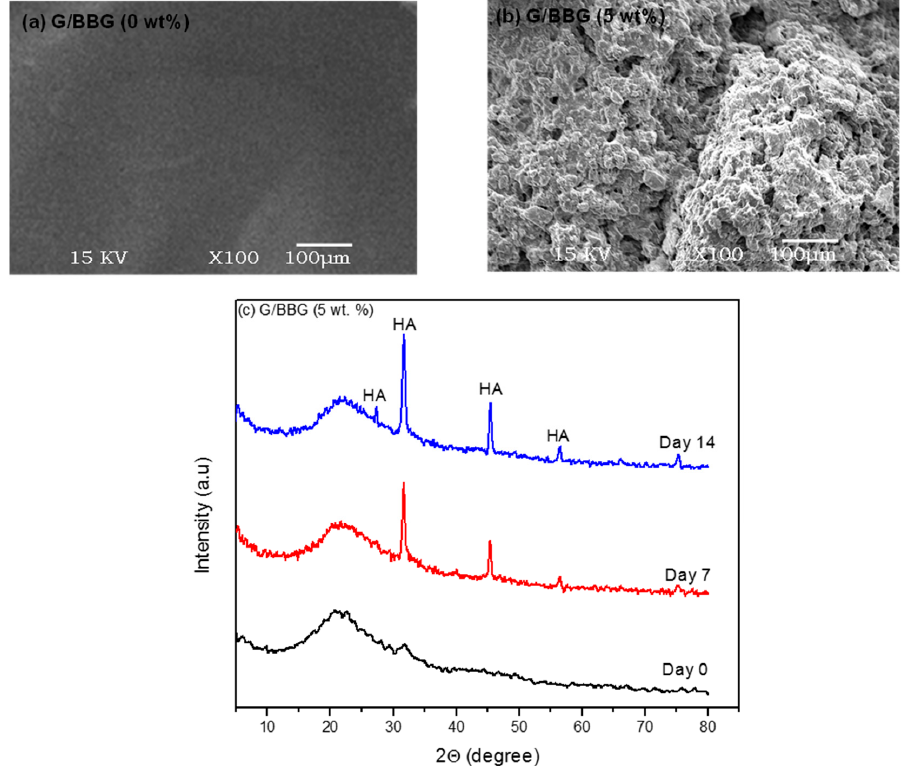
Figure 10. The effect of BBG on the apatite-forming ability of G/BBG nanocomposite hydrogels: ( a ) and ( b ) SEM images showed the better apatite-forming ability after 14 days with the addition of 5 wt.% BBG and ( c ) XRD patterns indicated the HA formation.